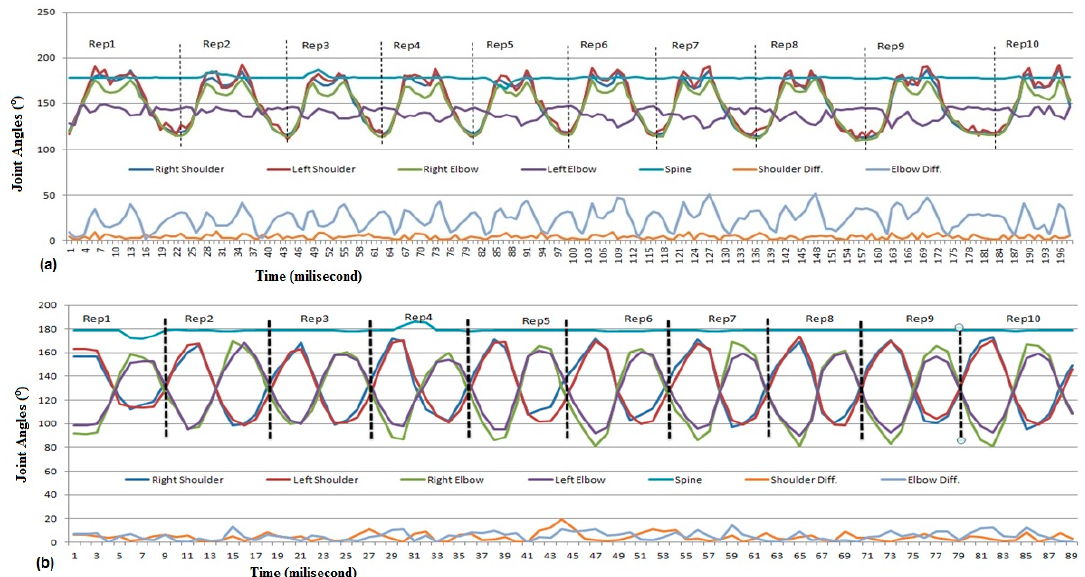
Figure 7. Sample LR and DSP training results: ( a ) angle displacement for LR; ( b ) angle displacement for DSP.